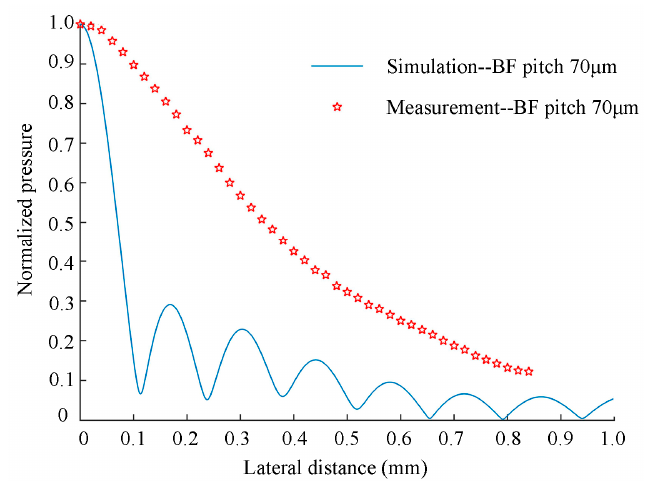
Figure 12. Measured acoustic beam-pattern compared with simulation results for a 32-element array with a 70 μ m beam-forming pitch.